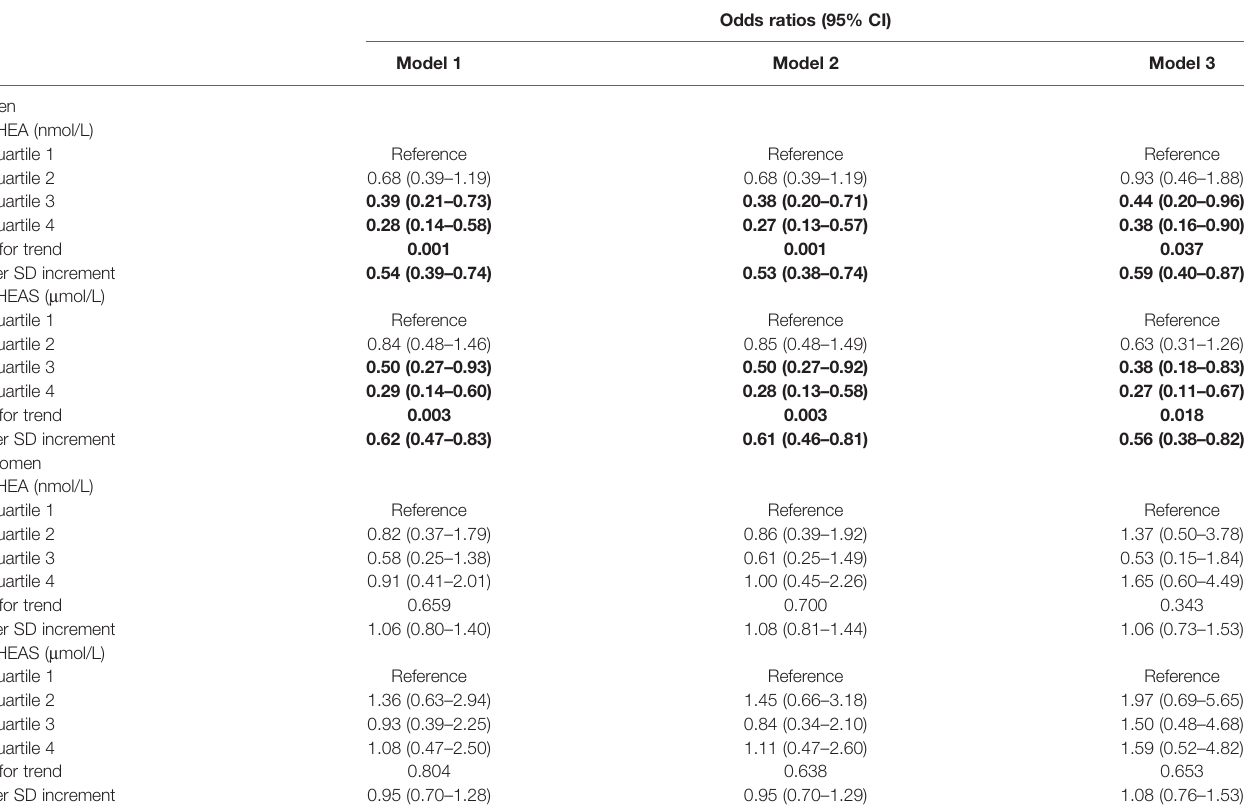
TABLE 2 | Odds ratios of CHD by different DHEA and DHEAS status in patients with type 2 diabetes